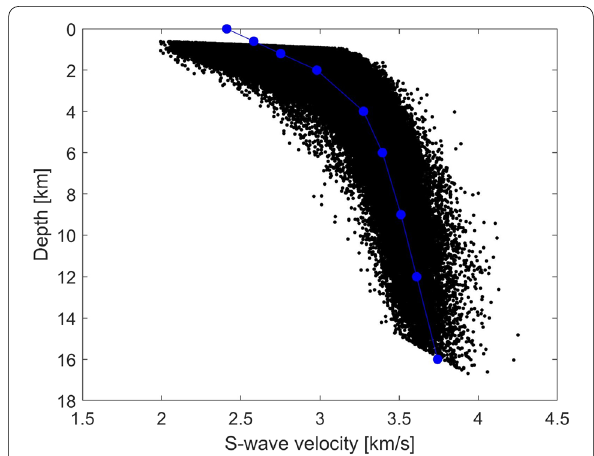
Fig. 4 The initial S-wave velocity model used as a reference in the inversion process. The blue line and blue dots represent the average S-wave velocity model. The black dots represent all the interstation Rayleigh wave phase velocity dispersion curves measured using the zero-crossing method transformed to a depth–S-wave velocity approximation